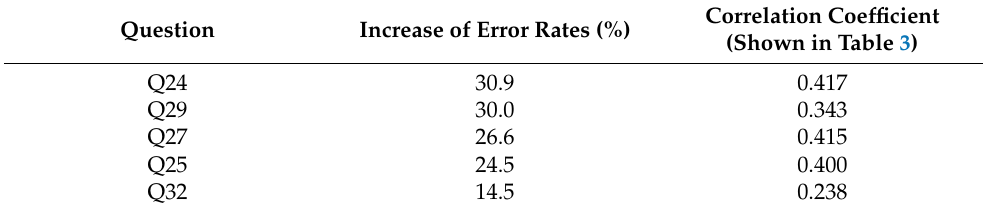
Table 4. Questions with large error